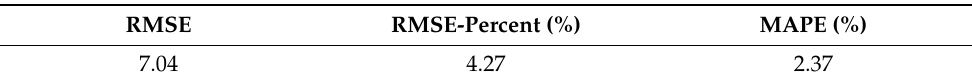
Table 11. RMSE and MAPE values of the CONTAM simulation of the CO 2 concentration in A elementary school.